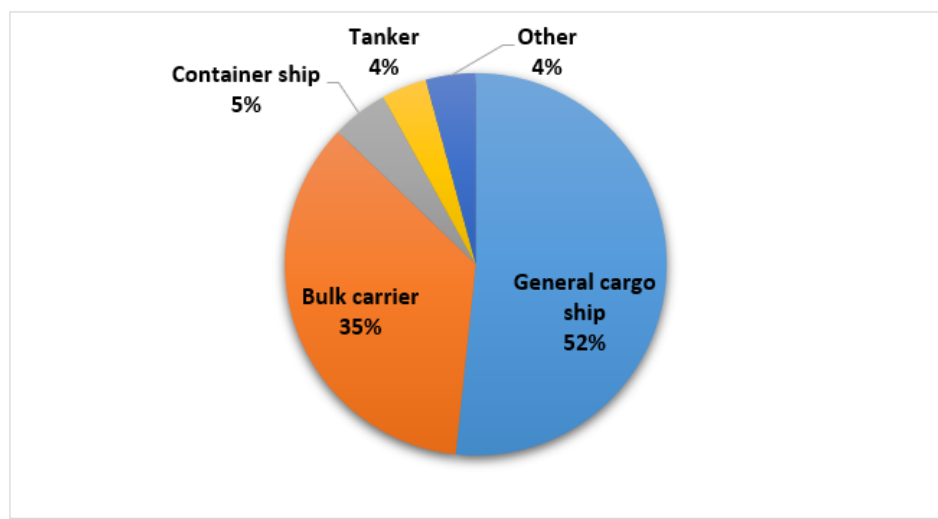
Figure 3. Percentage of total ballast discharged in the Port of Ploče by specific ship type.